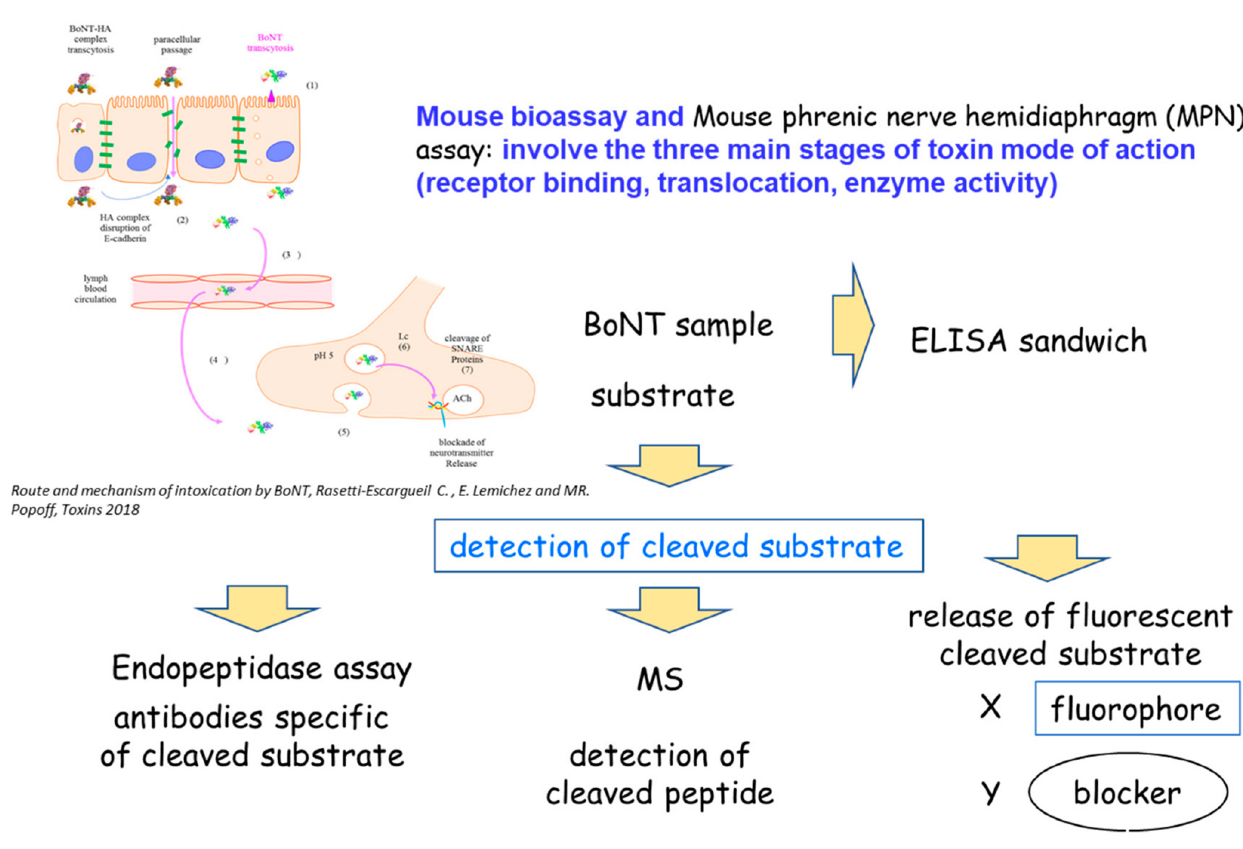
Figure 1. Detection principles.